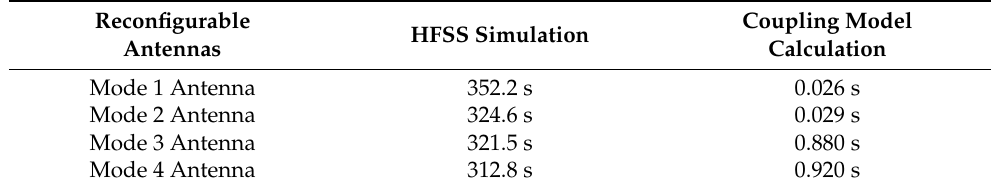
Table 18. Comparison between the computation time by HFSS simulation and the coupling model